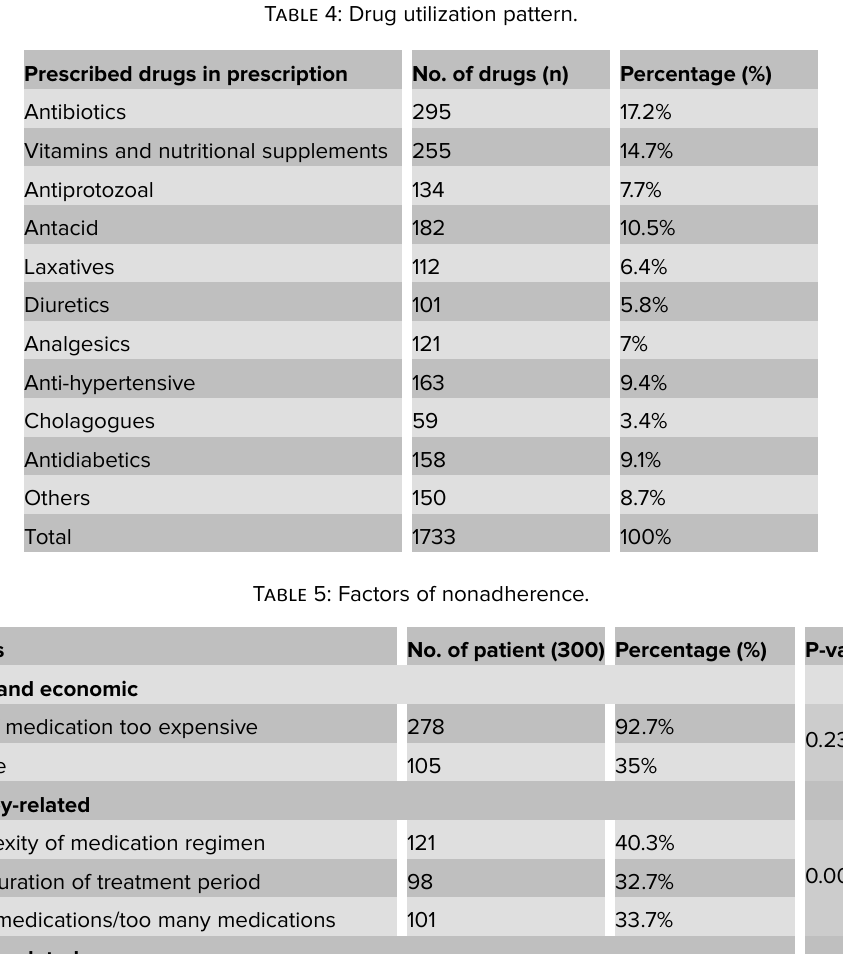
TABLE 4: Drug utilization pattern.